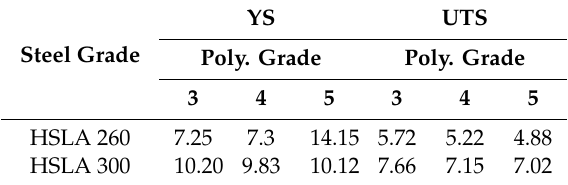
Table 5. Study of the error (MPa) with di ff erent polynomial